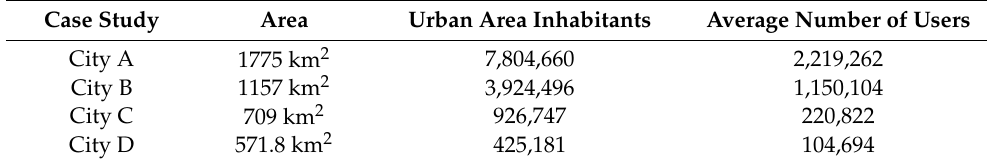
Table 1. Case study information